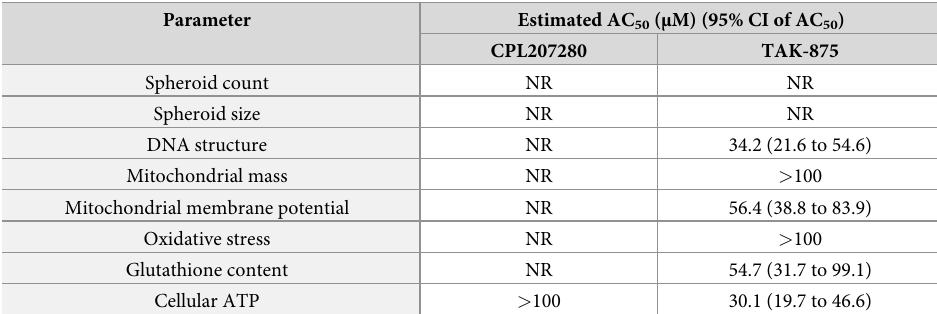
Table 1. Effects of CPL207280 and TAK-875 on pivotal hepatocyte health